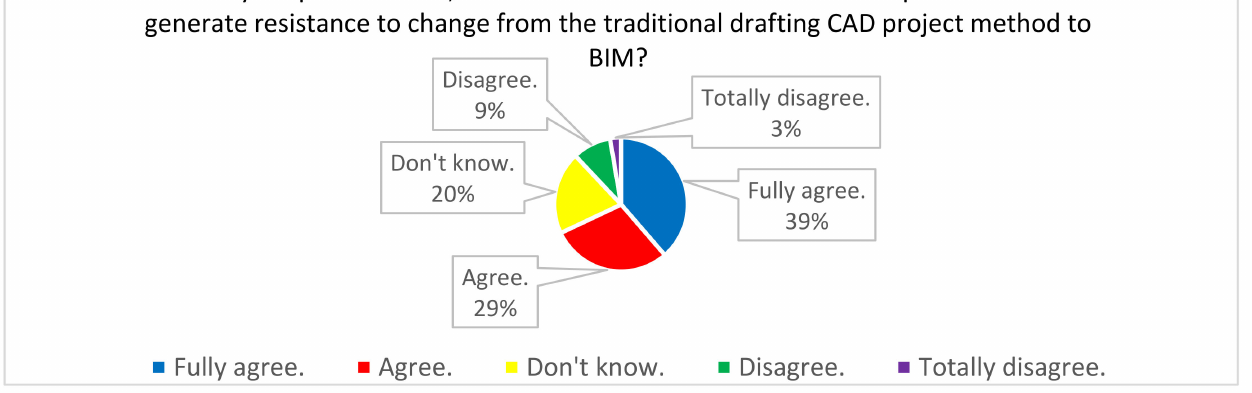
Figure 9. Answers to the seventh question. Source: authors